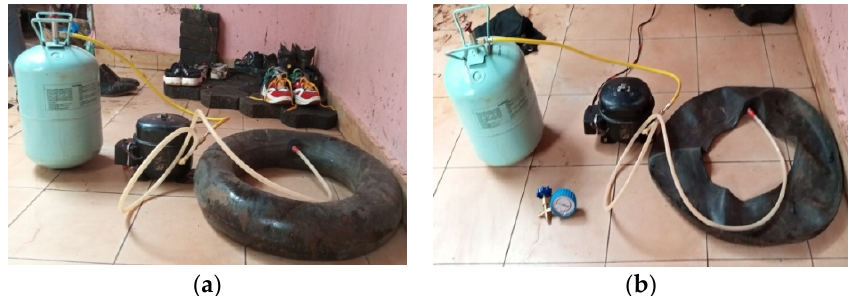
Figure 3. Compression of biomethane ( a ) full and ( b ) empty balloon. Bottle Characteristics